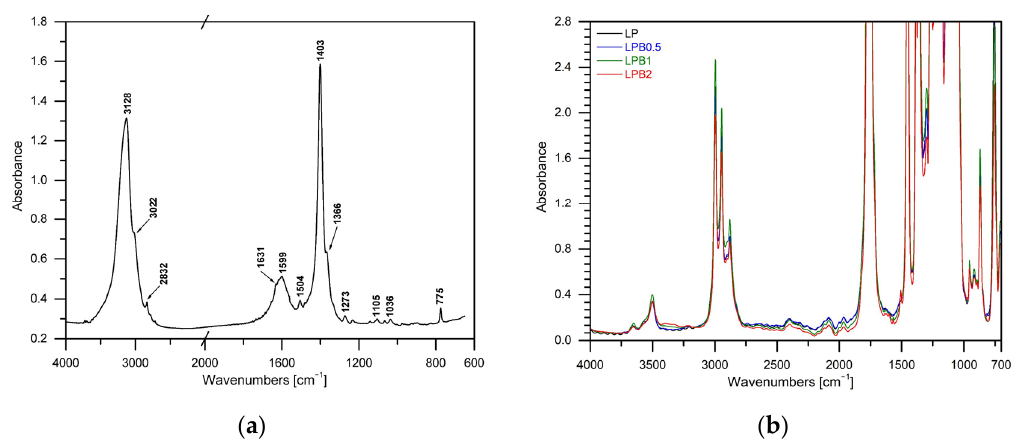
Figure 2. FTIR spectrum of berberine ( a ) and FTIR spectra of the PLA-based materials ( b ).